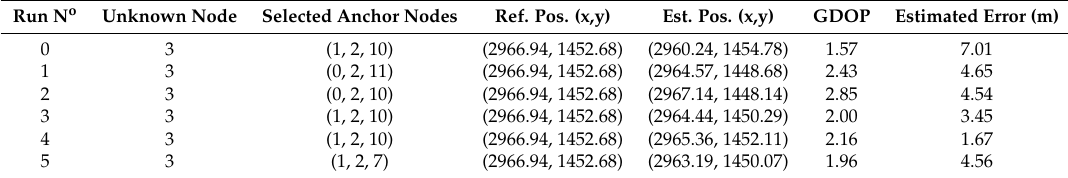
Table 2. Geometric Dilution of Precision (GDOP)